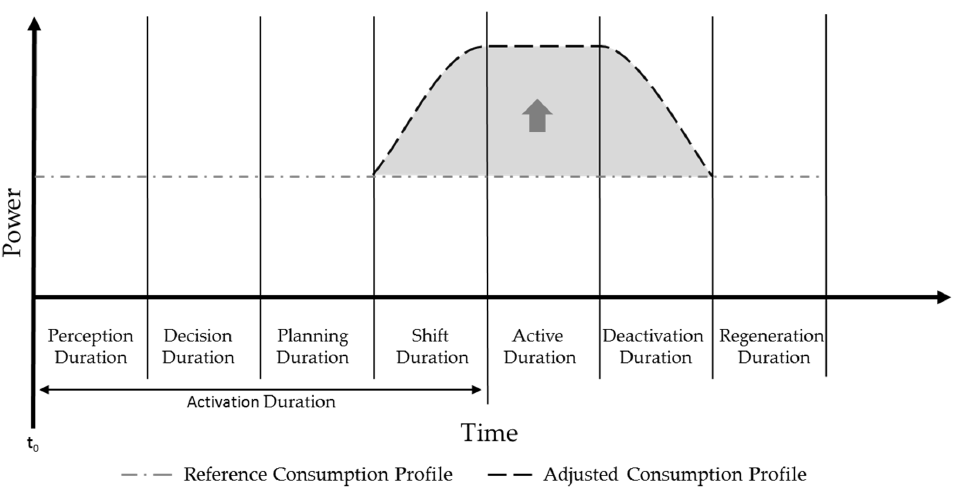
Figure 6. Duration parameters describing the complete execution of an EFM (Adapted from Reference [23], own illustration).